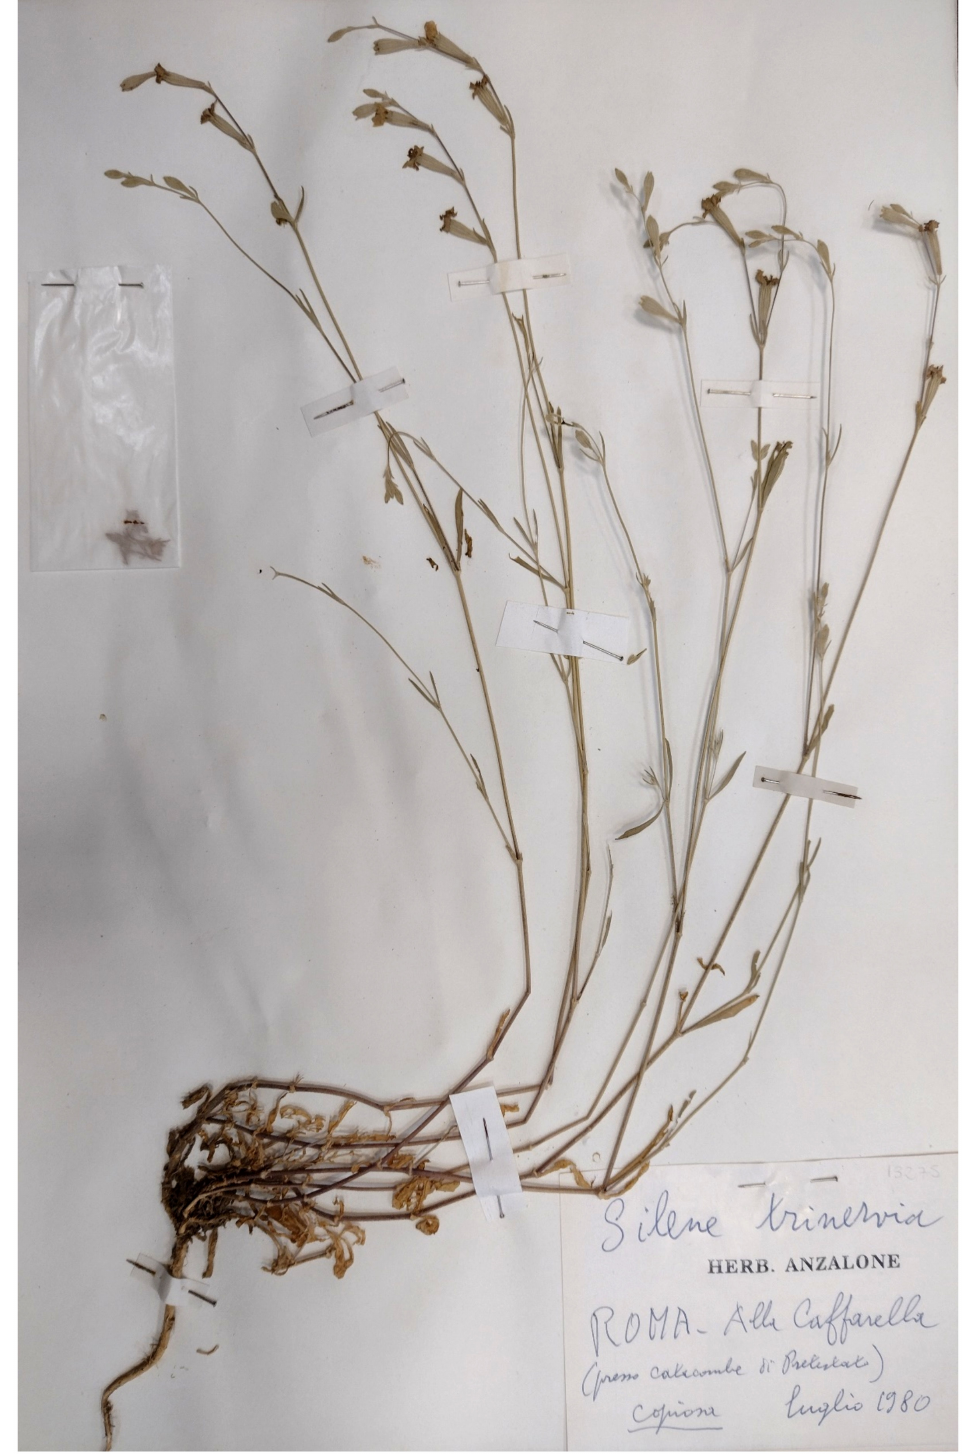
Figure 68. Specimen of Silene gallinyi (sub S. trinervia ) collected in Caffarella valley in July 1980 (RO-Herbarium Anzalone no.